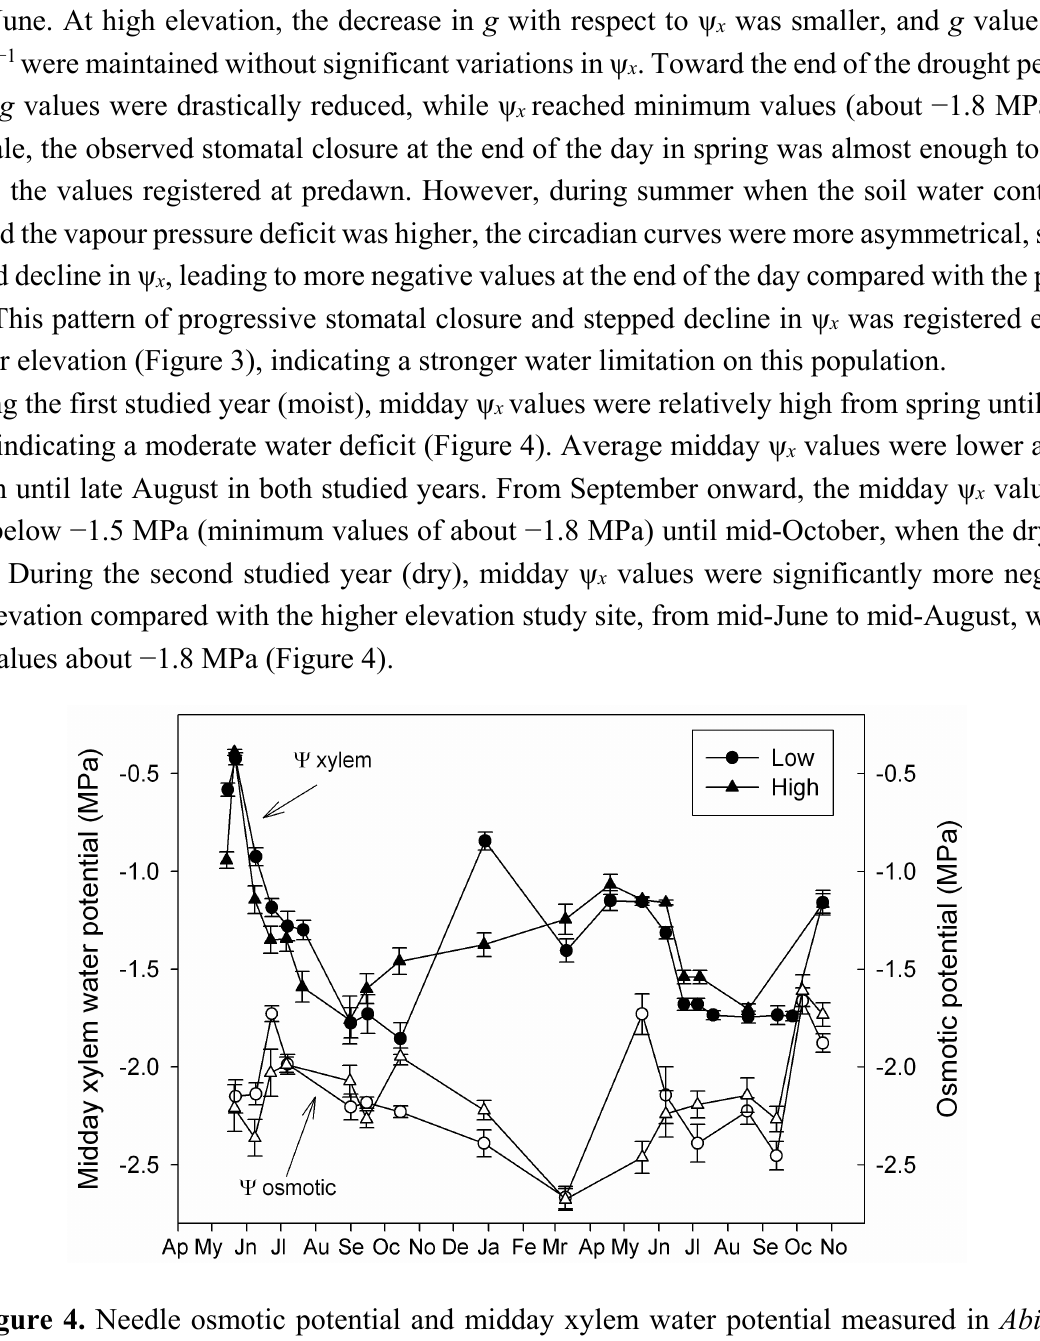
Figure 4. Needle osmotic potential and midday xylem water potential measured in Abies pinsapo trees along an altitudinal gradient (low elevation, 1200m; high elevation, 1550 m) during two consecutive growing periods. Errors bars represent the standard error; significant differences between stands were tested by repeated measured MANOVA. ψ x n = 5 trees (3 twigs per tree) per elevation; ψ π n = 12 trees (2 twigs per tree) per